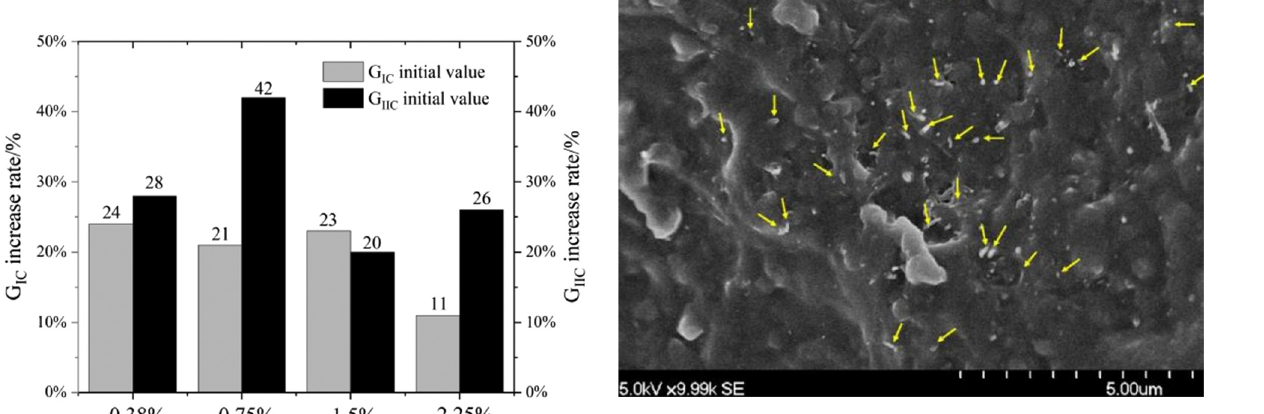
Figure 16: CNTs random fi lm surface density to increase the rate of G IC and G IIC . Data from ref. [ 68 ] .